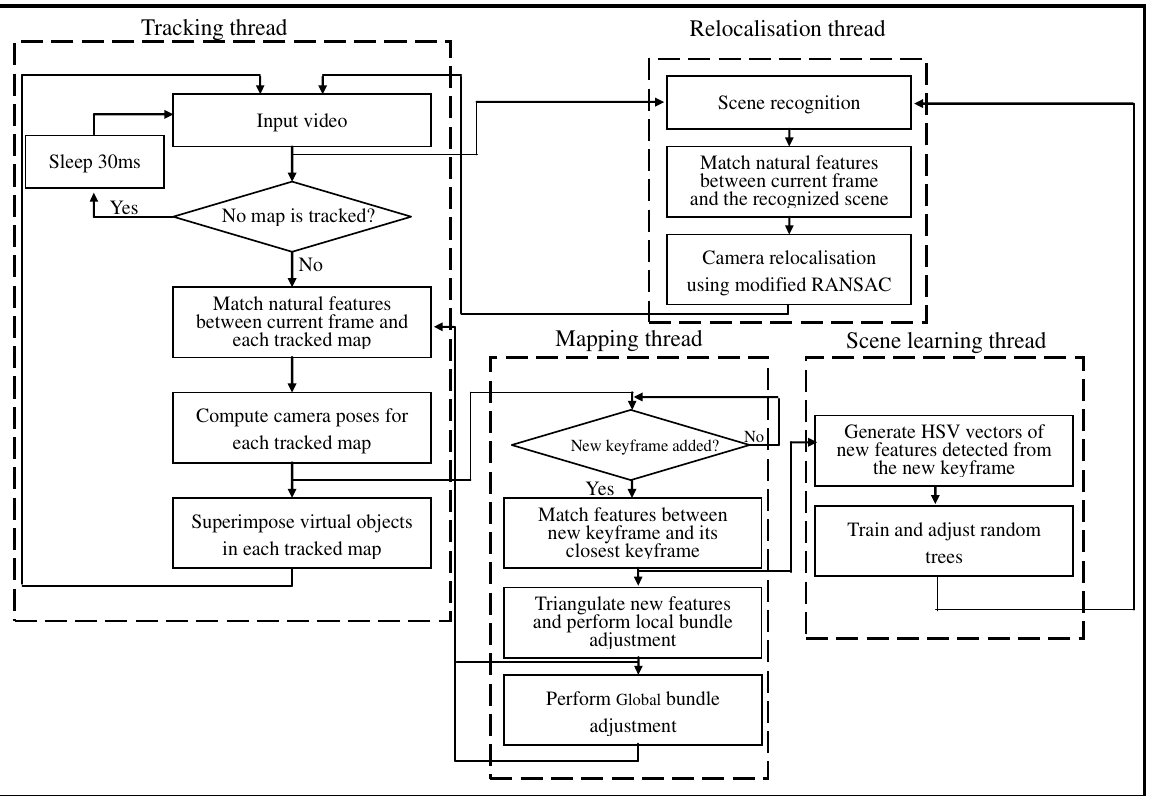
Figure 5. Multithread based registration